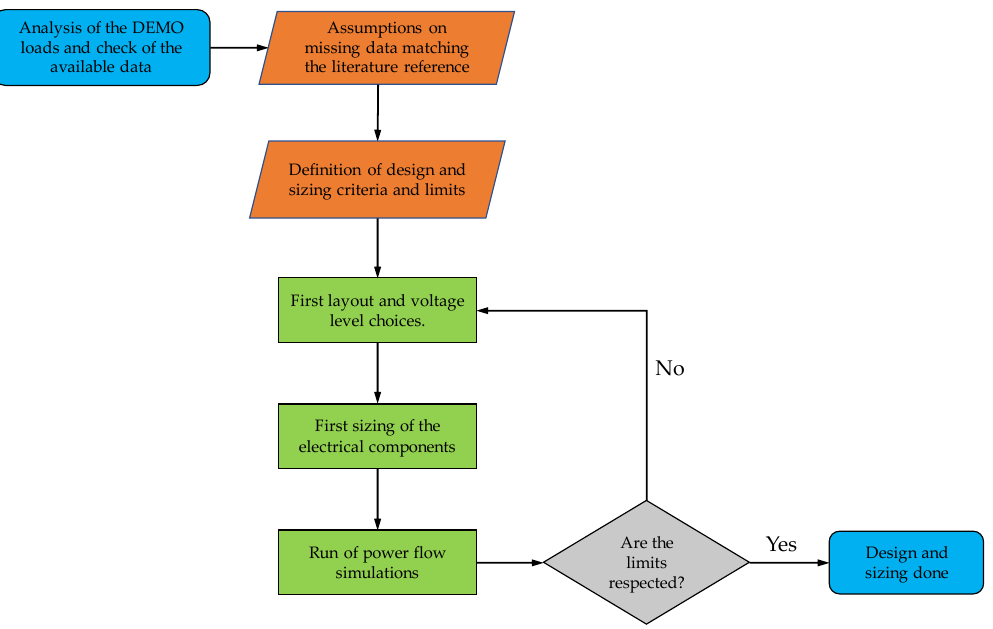
Table 4. Electrical data of the HV/MV transformers.